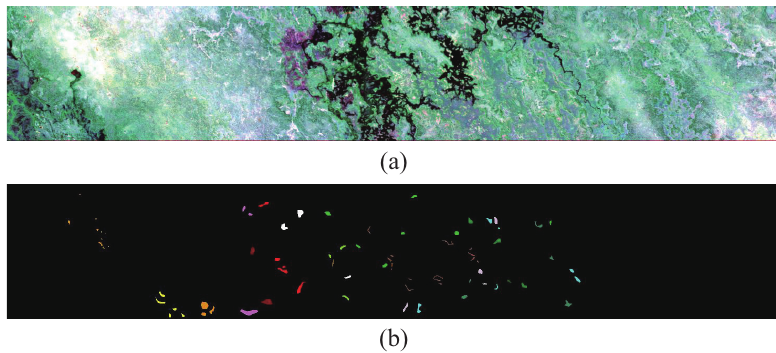
Figure 7. Botswana data set. ( a ) Pseudocolor image. ( b ) Ground-truth